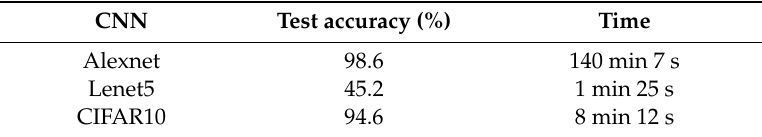
Table 1. Ultimate accuracy and training time of ROI recognition by Alexnet, Lenet5, and CIFAR10, respectively.